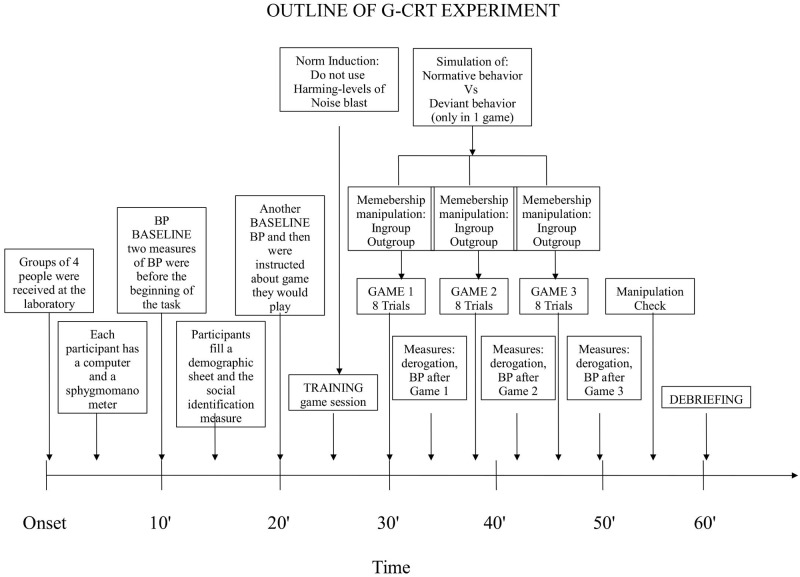
Experiment outline.